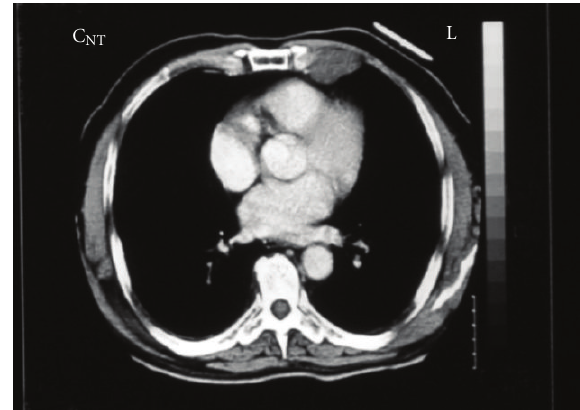
Figure 3: Computed tomography shows a homogeneous large cystic mass with a small solitary nodular area at the inferior margin.